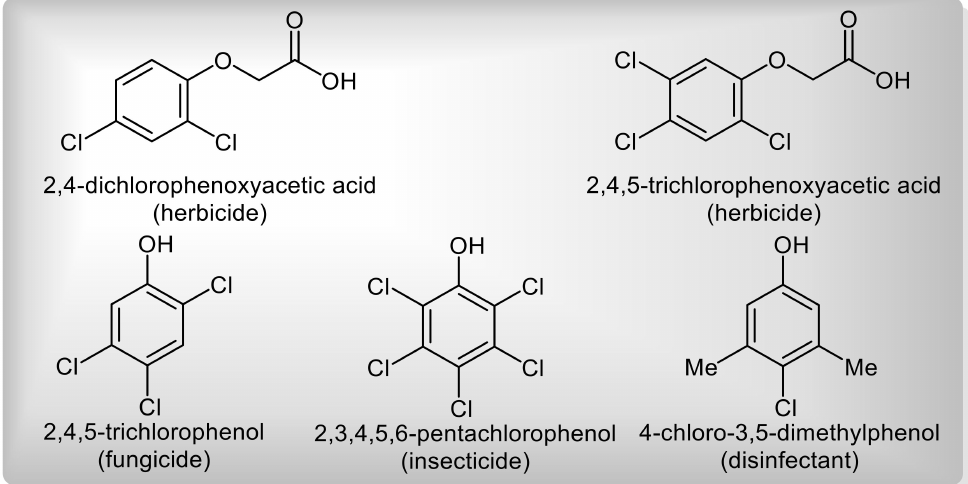
Figure 1. Common industrial products containing chlorinated